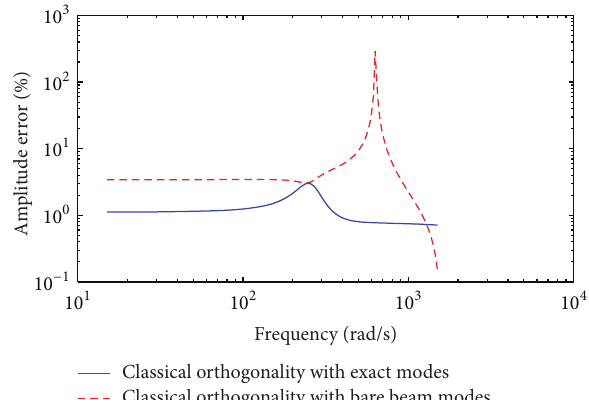
Figure 11: Frequency response amplitude error of a simply sup- ported beam carrying one in-span mass-spring-damper-mass sys- tem for 𝑘 = 190428 N/m, 𝑀 𝑑 = 3.0775 kg, 𝑀 𝑐 = 0 kg, 𝑇 = 0 N, = 0.1 Ns/m, and 𝐿 = 0.75 𝐸𝐼 = 63476.1 Nm 2 , 𝑐 𝑑 𝑑